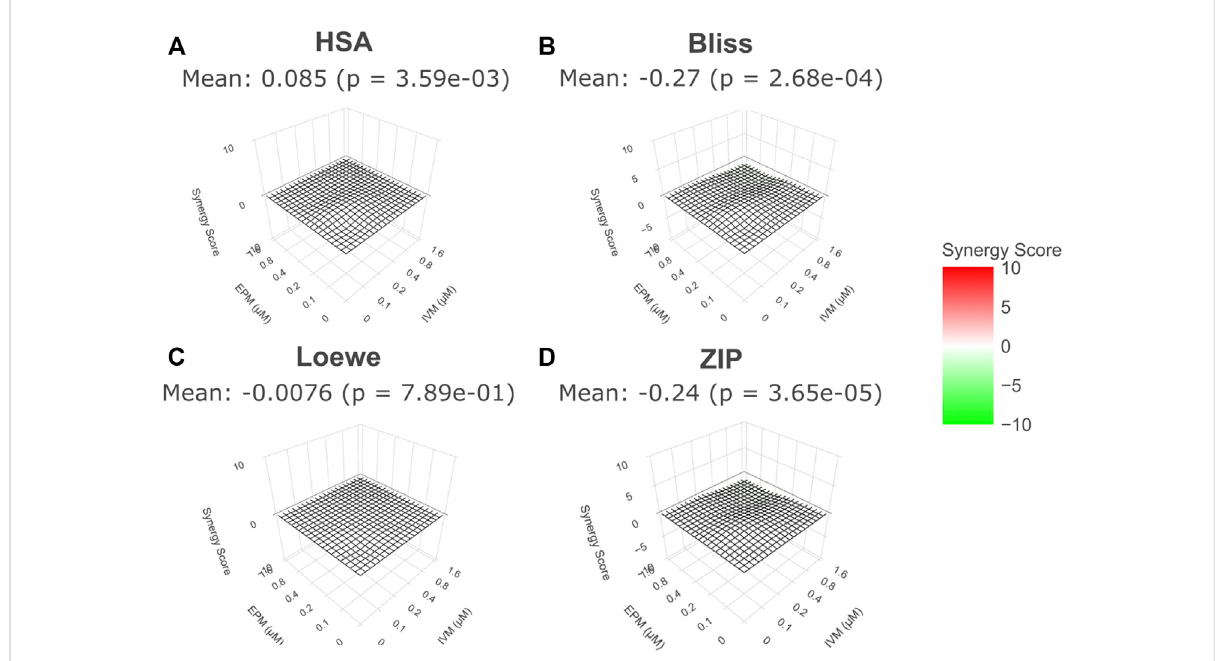
FIGURE 4 3D surface of Synergy Scores for EPM and IVM drug-drug interaction . For all models, EPM and IVM interaction landscapes are shown in 3D (A) . Highest Single Agent model (HAS) (B) . Bliss Independence model (BLISS) (C) . Loewe model (LOEWE) (D) . Zero Interaction Potency model (ZIP). 90 min exposure time is shown in all cases. The mean value of Synergy Score is indicated in the SD surface ( p value compared to 0% inhibition). No signi fi cant synergy (red) or antagonism (green) between EPM and IVM at all